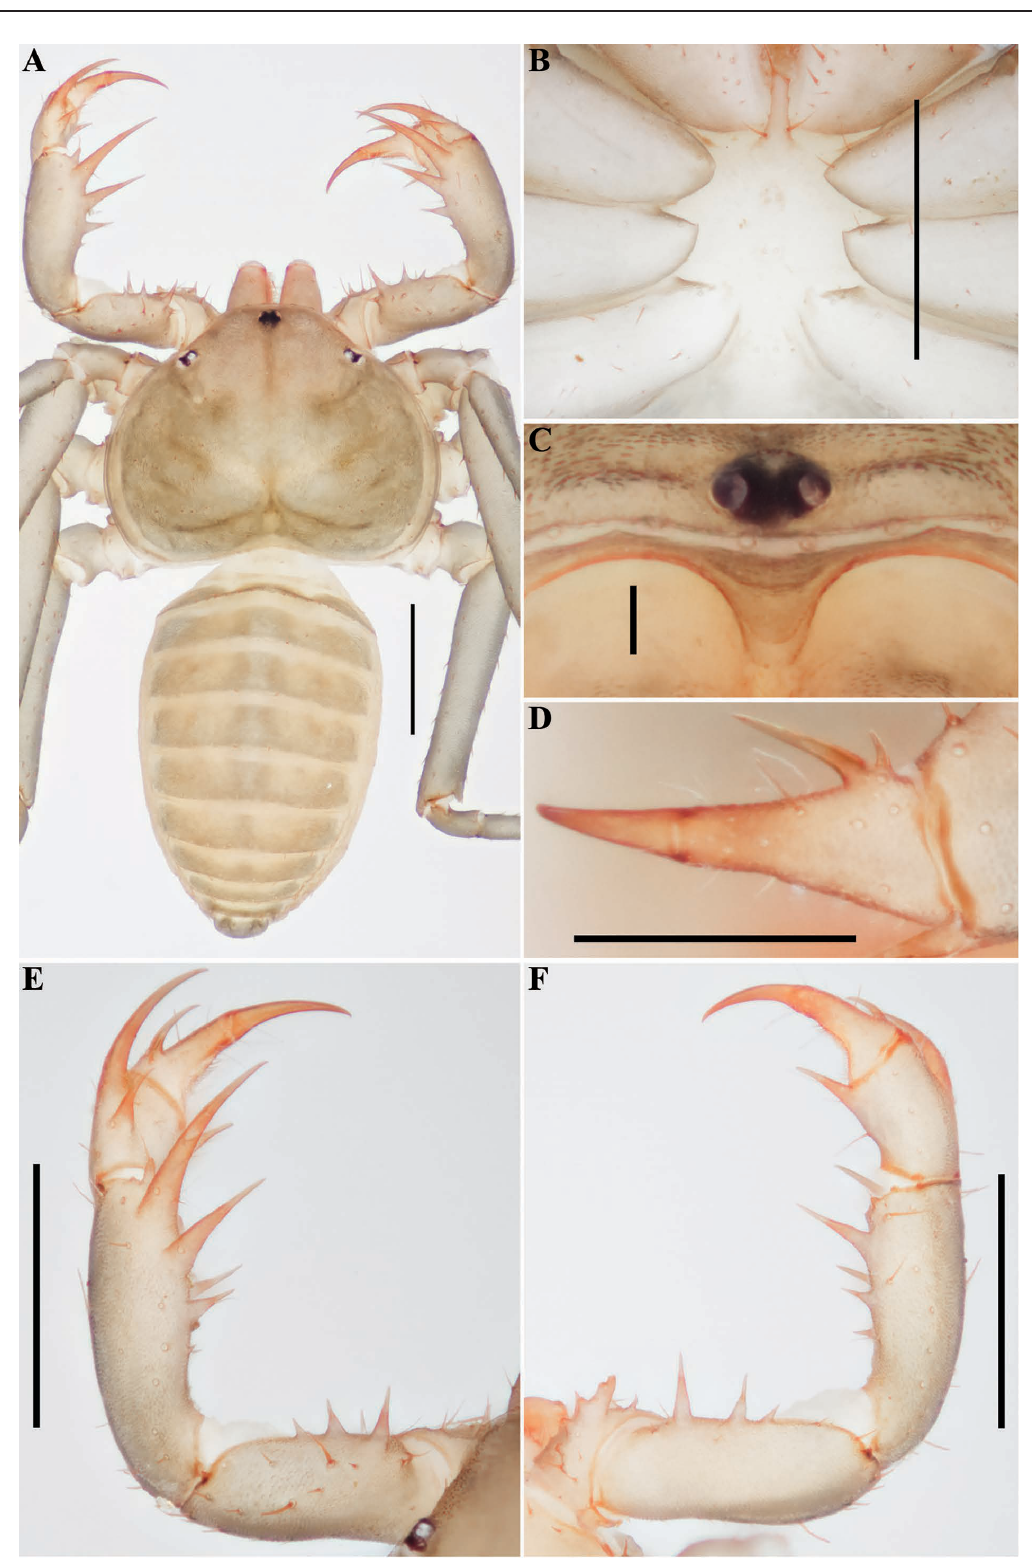
Fig. 137. Sarax bispinosus (Nair, 1934) (AMCC [LP 12298]), general morphology, ♂ . A . Habitus, dorsal view. B . Sternum, ventral view. C . Frontal process. D . Pedipalp tarsus, frontal view. E . Pedipalp, dorsal view. F . Pedipalp, ventral view. Scale bars: A–B, E–F = 1 mm; C = 0.1 mm; D =